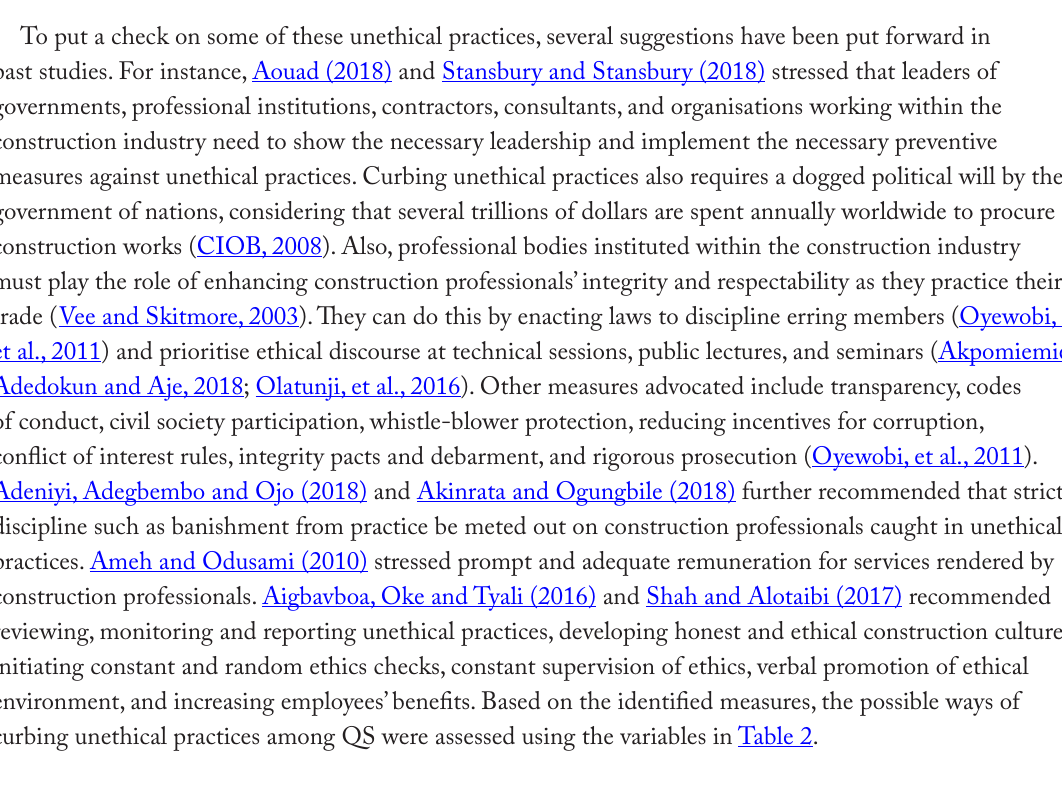
Measures for curbing unethical practices of QS Measures